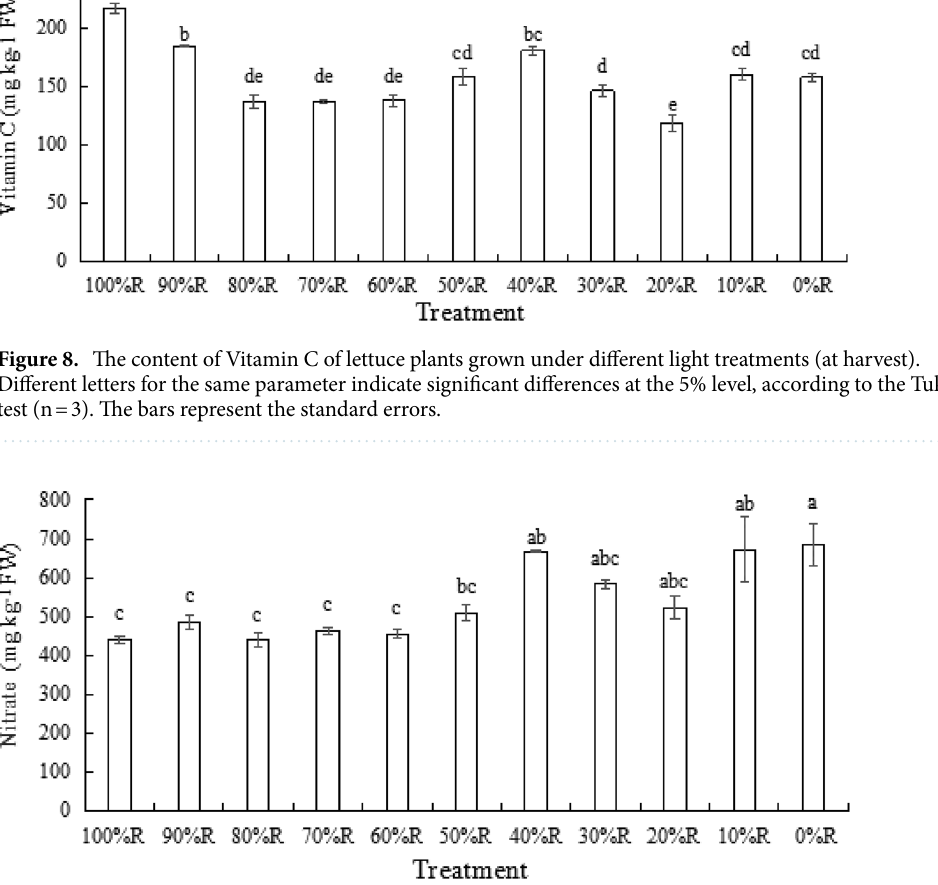
Figure 9. The contents of nitrate of lettuce plants grown under different light treatments (at harvest). Different letters for the same parameter indicate significant differences at the 5% level, according to the Tukey’s test (n = 3). The bars represent the standard